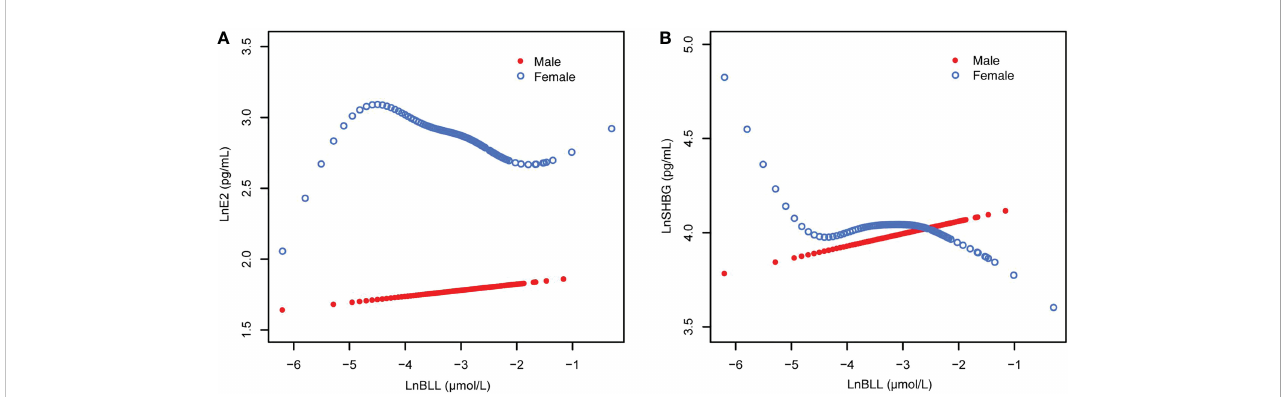
FIGURE 2 The associations of BLL with E2 and SHBG, strati fi ed by age. (A) BLL and E2 dose – response relationship. Adjusted for age, ratio of family income to poverty; total energy, cholesterol, Ln(iron) and Ln(zinc) intake on the fi rst day; fi sh eaten during the past 30 days, moderate recreational activities, body mass index and Ln(serum copper). (B) BLL and SHBG dose – response relationship. Adjusted for age, ratio offamily income to poverty; total energy, Ln(iron) and Ln(zinc) intake on the fi rst day; fi sh eaten during the past 30 days, moderate recreational activities, body mass index, hematocrit, serum continine, Ln(serum albumin), Ln(serum copper) and Ln(serum zinc). BLL, Blood lead levels; E2, Estradiol; SHBG, Sex hormone-binding